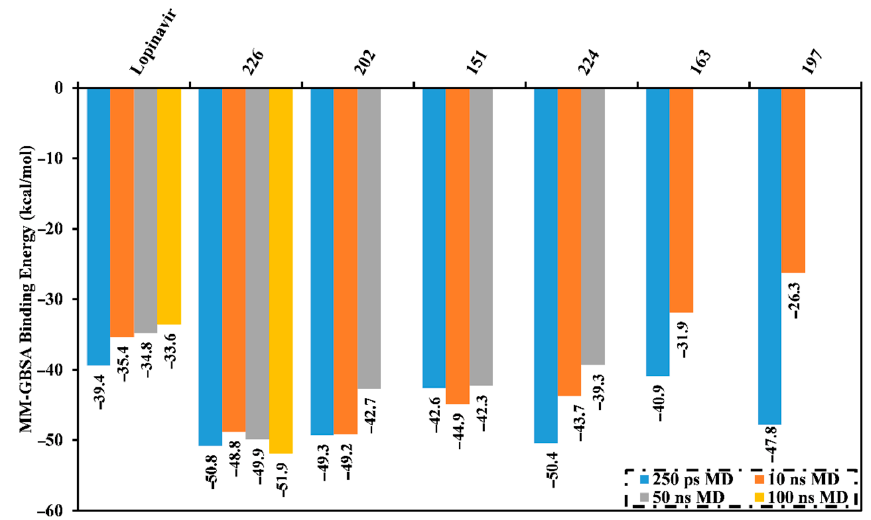
Figure 2. Average molecular mechanics/generalized Born surface area (MM/GBSA) binding energies for lopinavir and the top natural products complexed with M pro over 250 ns in an implicit water solvent, and 10 ns, 50 ns, and 100 ns molecular dynamics (MD) simulations in an explicit water solvent.